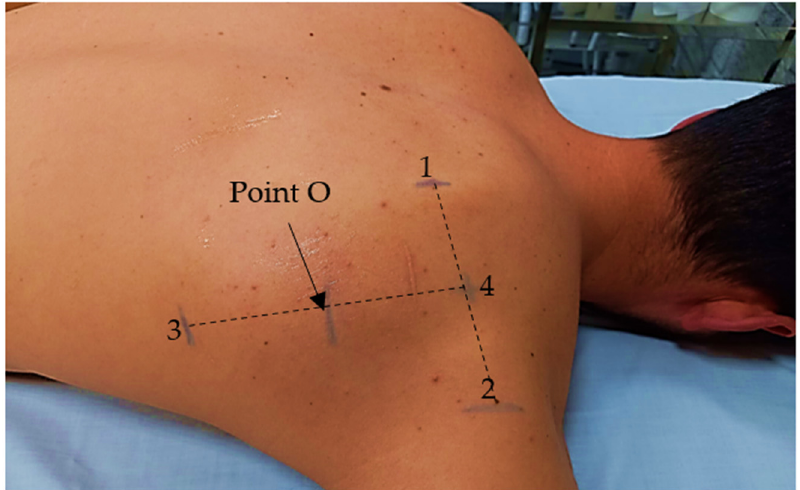
Figure 2. Measurement site protocol: 1: vertebral limit of the scapula spine; 2 spinoglenoid notch; 3: scapula inferior angle: 4: midpoint between 1 and 2; 5: Point O (midpoint between 3 and 4).